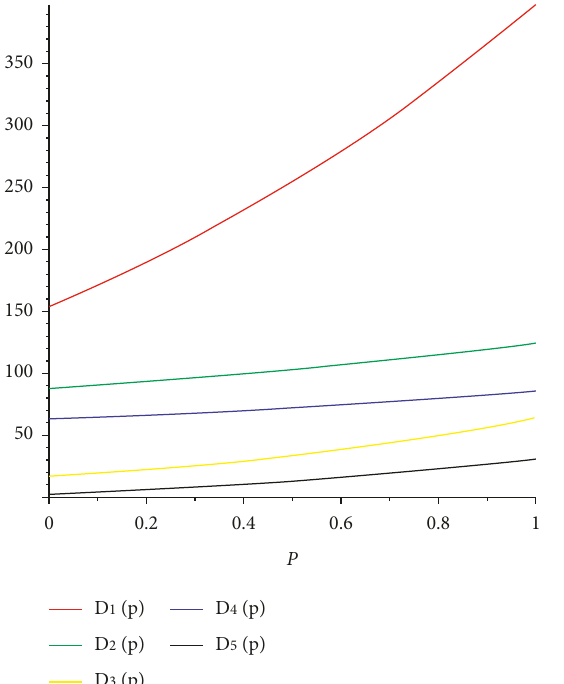
Figure 8: Comparison of KBR